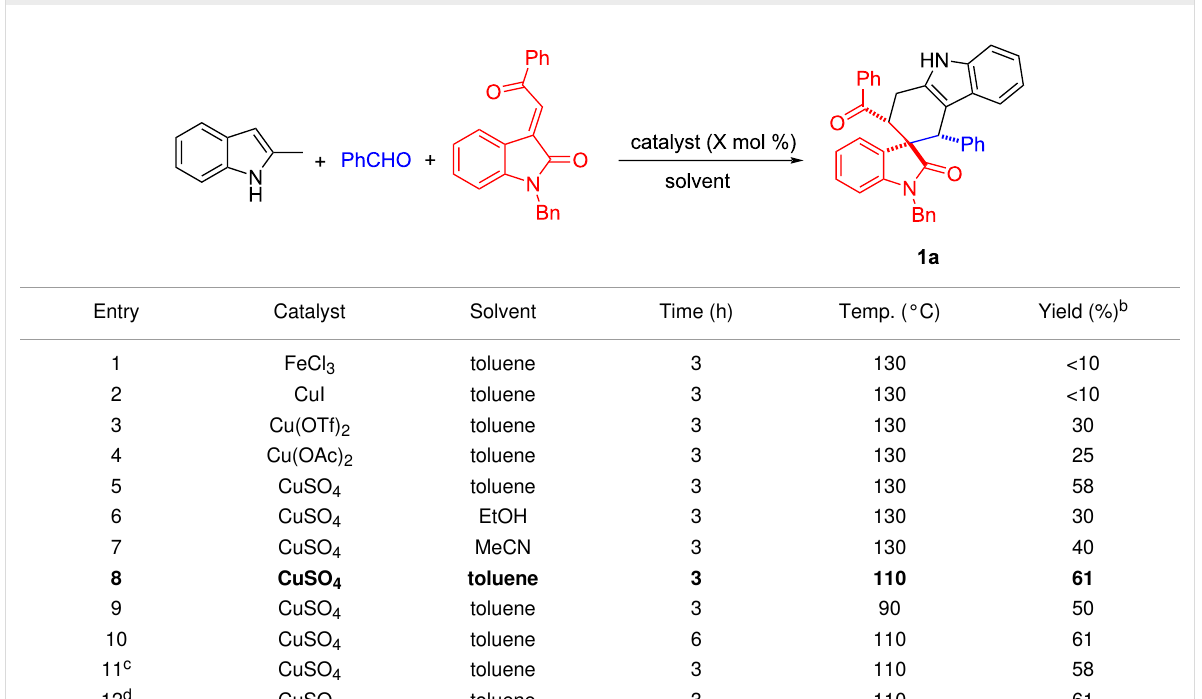
Table 1: Optimization of reaction conditions a